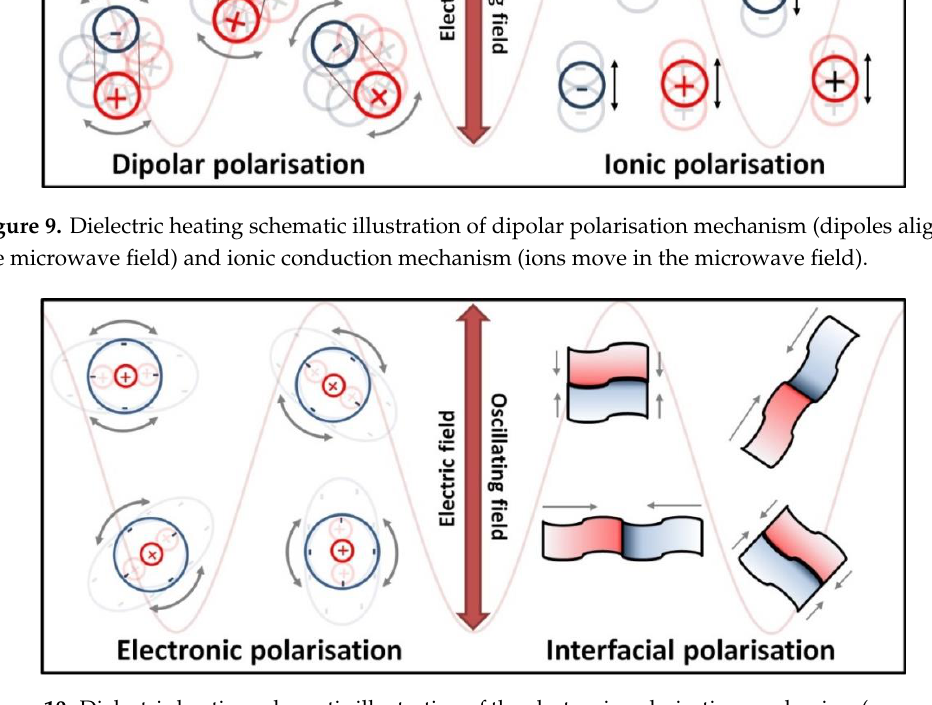
Figure 10. Dielectric heating schematic illustration of the electronic polarisation mechanism (movement of charges in the microwave field) and the interfacial mechanism (accumulation of charges on the interface between two different surfaces).